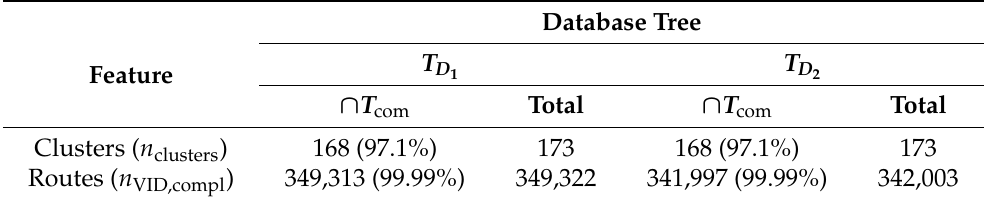
and T D with T com 2 1